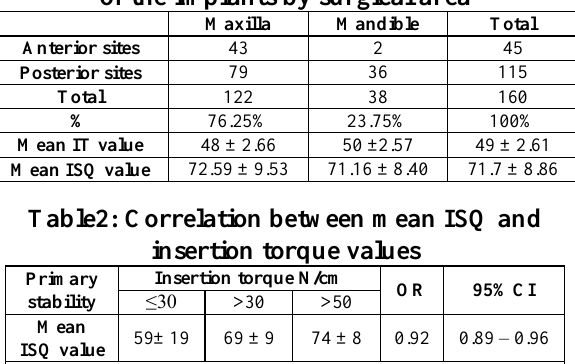
Table 1: Distribution and mean PIT and ISQ of the implants by surgical area